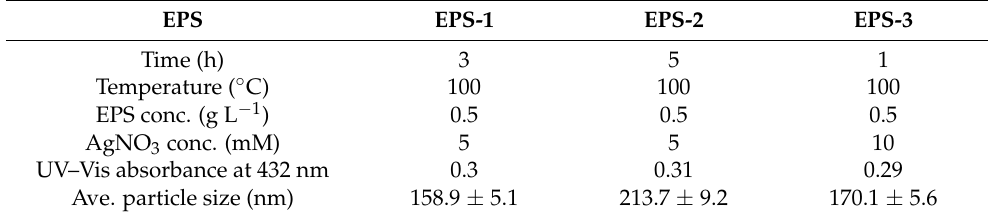
Table 2. Summary of the optimal conditions for the synthesis of Ag NPs with three fractions of EPS.